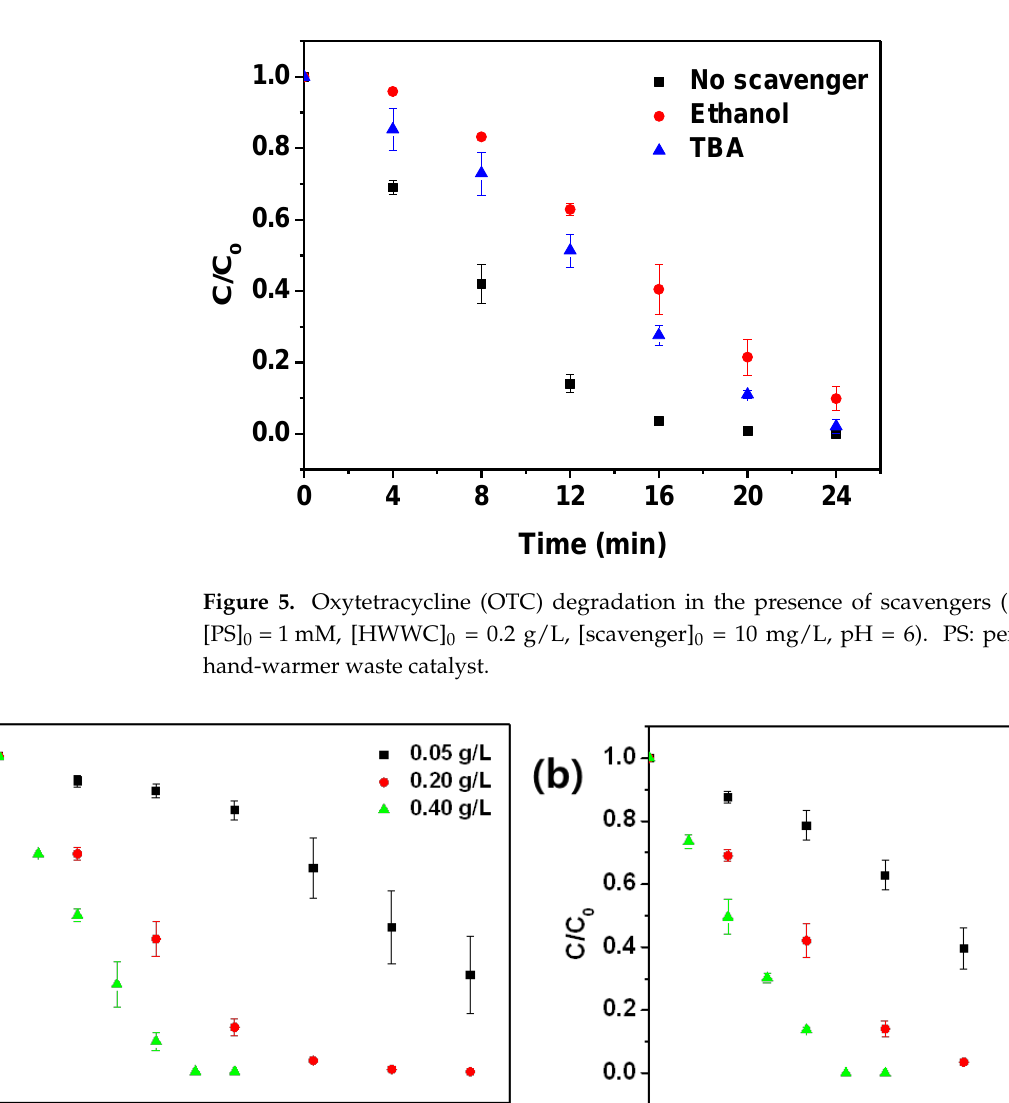
Figure 5. Oxytetracycline (OTC) degradation in the presence of scavengers ([OTC] 0 = 20 μM, [PS] 0 =